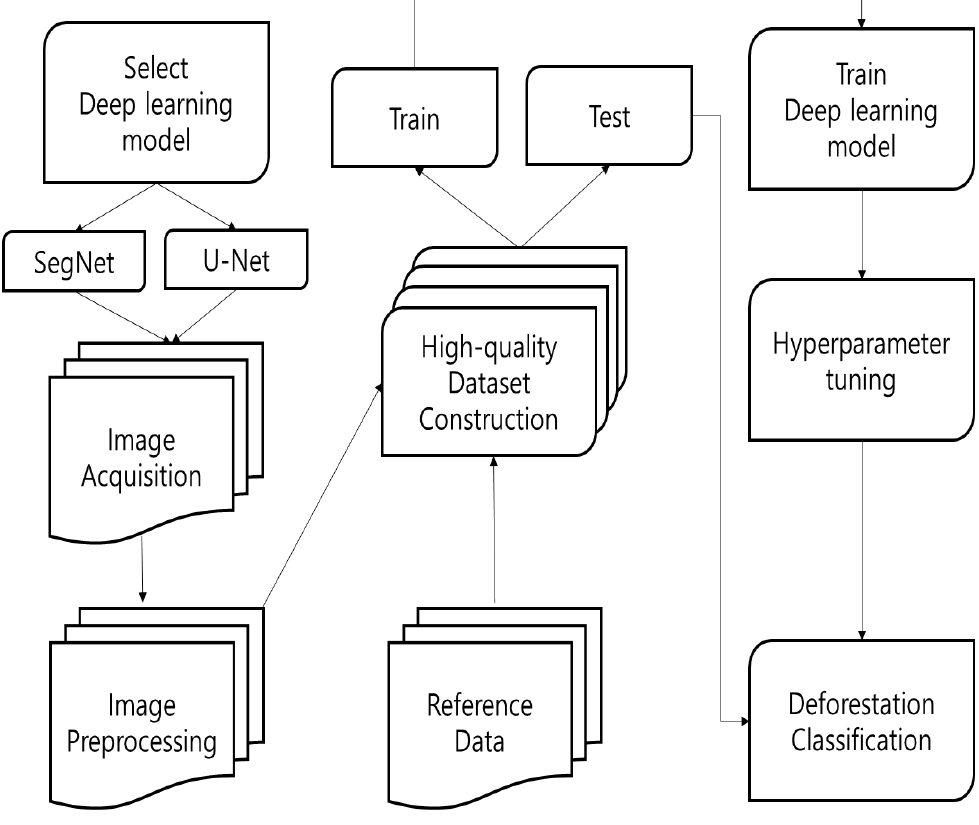
Figure 1. Flow chart in this study.